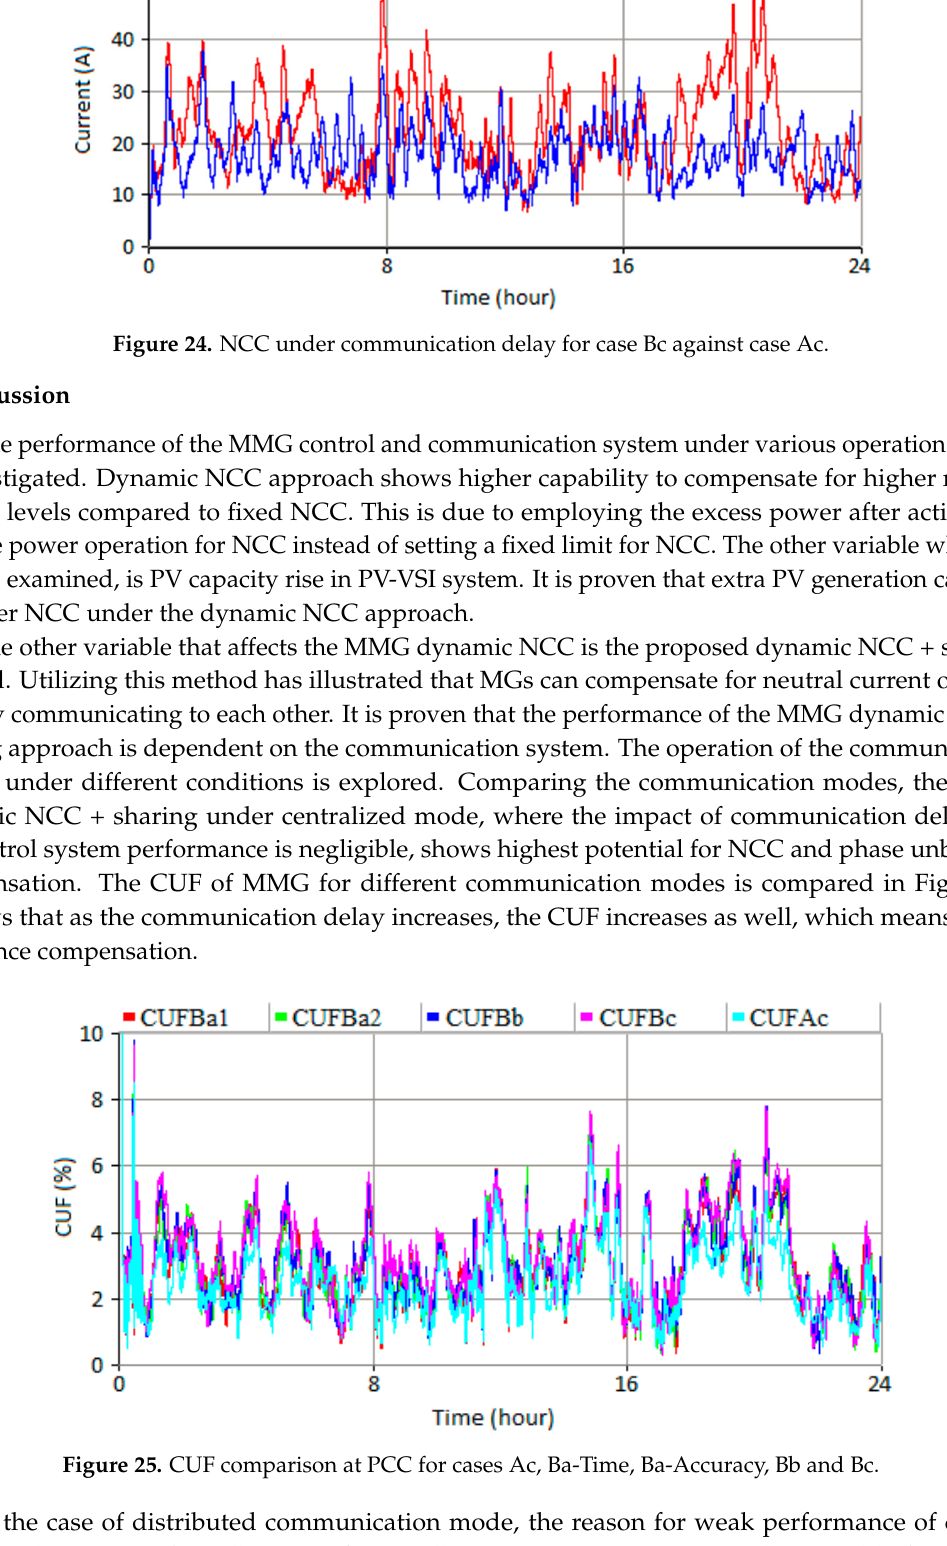
Figure 23. Communication delay implementation for case Bc.